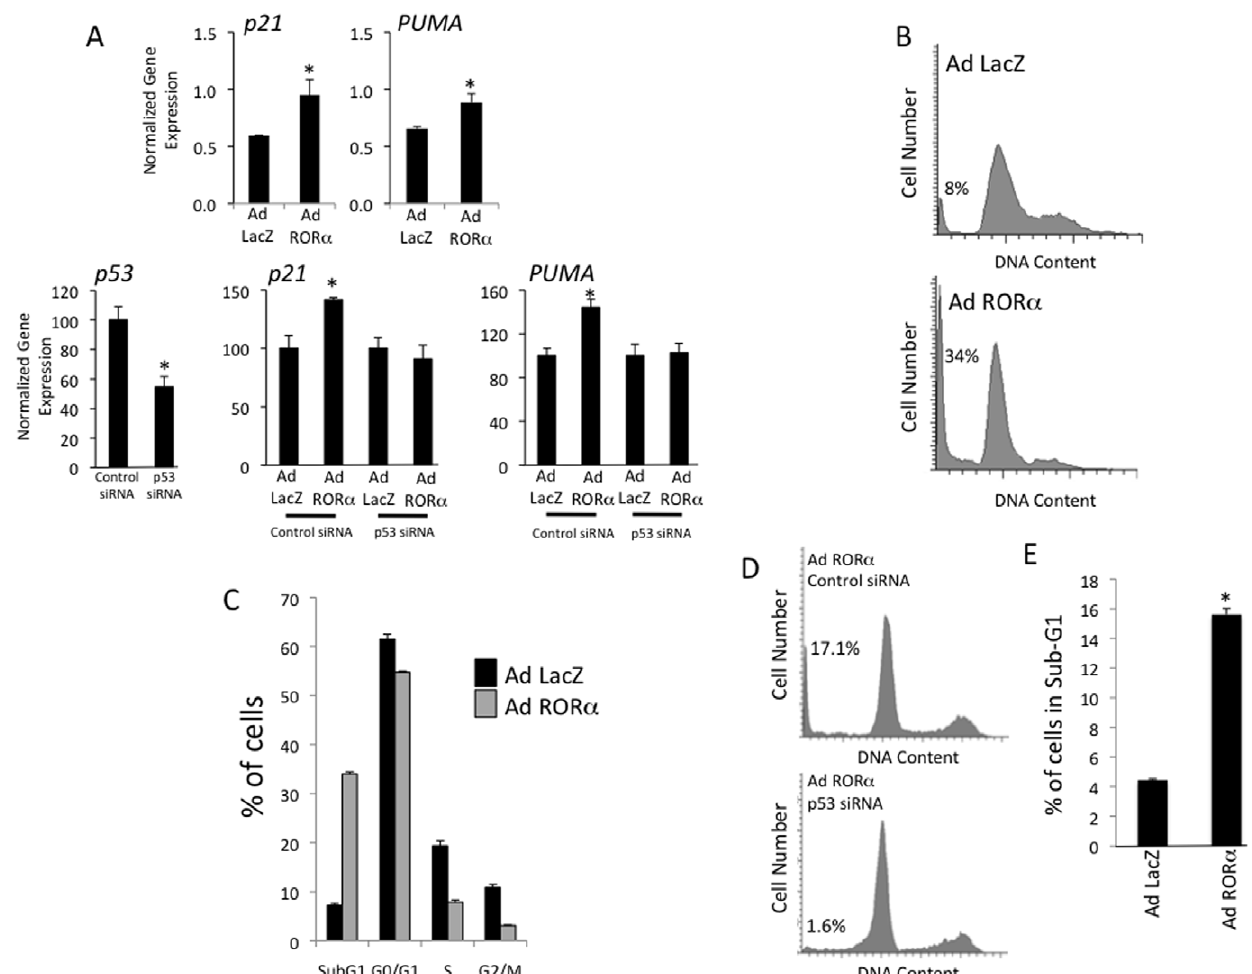
Figure 2. ROR a regulates p53 function. A.) Overexpression of ROR a in HepG2 cells results in increased expression of p53 target genes including p21 , BAX , and PUMA . In control cells where the ROR a adenovirus was not included, a control LacZ adenovirus was used. *, indicates p , 0.05. Experiments shown in the lower panels were performed identical to the upper panels with the exception of inclusion of siRNA treatments as indicated. B) Cell cycle analysis of control HepG2 cells infected with LacZ adenovirus (top) or ROR a adenovirus (bottom). C) Analysis of the number of cells in various stages of the cell cycle in control or ROR a overexpressing HepG2 cells. D) Cell cycle analysis of HepG2 cells overexpression ROR a (adenovirus treatment) after treatment with either control siRNA or p53 siRNA. E) Analysis of the number of MCF-7 breast cancer cells in sub-G1 infected with control adenovirus (LacZ) or ROR a adenovirus. *, indicates p , 0.05.